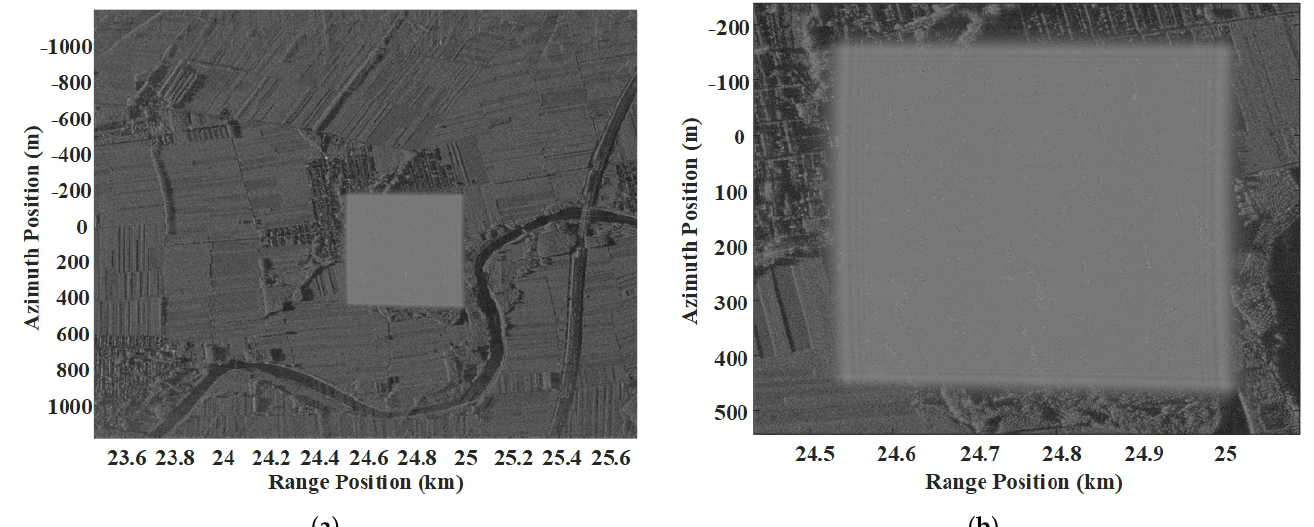
Figure 8. Imaging result of suppression jamming signal under specific modulation parameters. ( a ) Imaging result of jamming signal; ( b ) amplification diagram of jamming